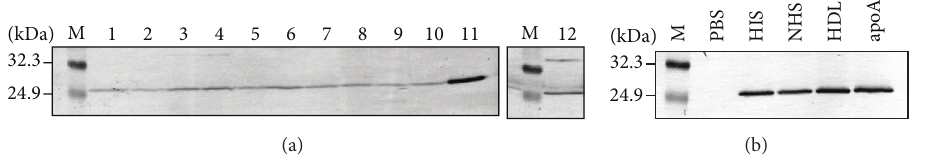
Figure 1: Interaction between bacteria and HDL. (a) The bacterial samples (lane 1: Pseudomonas aeruginosa , lane 2: Aeromonas species, lane 3: Klebsiella oxytoca , lane 4: Klebsiella pneumoniae , lane 5: Serratia marcescens , lane 6: Citrobacter koseri , lane 7: Pseudomonas aeruginosa , lane 8: Enterobacter cloacae , lane 9: Acinetobacter baumannii , lane 10: Stenotrophomonas maltophilia , lane 11: Mycobacterium avium, and lane 12: Escherichia coli ) were mixed with normal human serum (NHS). The NHS conjugated bacteria were washed and solubilized by means of lysis buffer. The lysates were separated by 12.5% SDS-PAGE and immunoblotted with anti-apoA-I antibody. The molecular weight markers are also shown (M). (b) M. avium was incubated with NHS, heat-inactivated serum (HIS), HDL, and apoA-I for 10min at 37 ∘ C. After washing with PBS, M. avium was solubilized and subjected to immunoblotting for apoA-I as described